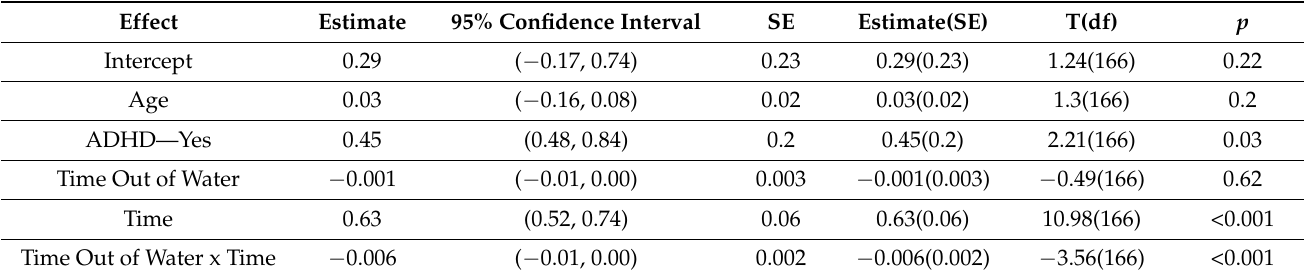
Table 1. Linear mixed-effects regression estimates, standard error of the estimate, 95% confidence interval, T -statistic, degrees of freedom, and p -values.